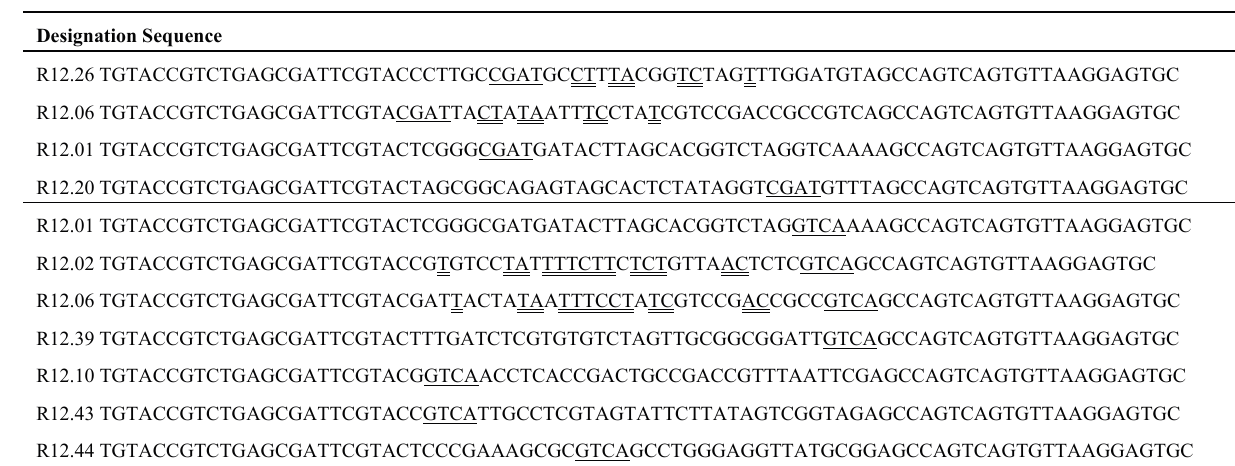
Table 2. Sequence families after 12 rounds of